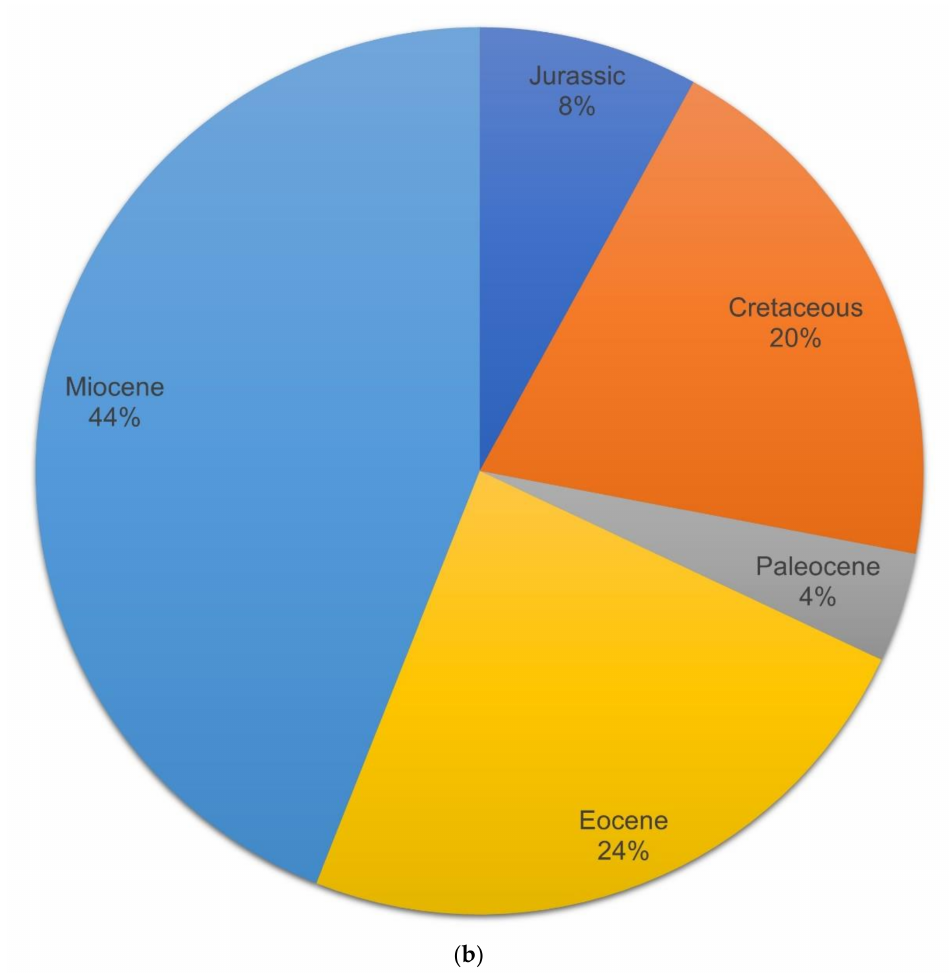
Figure 2. Porphyry copper deposits in the Andes. ( a ) Bar chart comparing estimated numbers of undiscovered deposits predicted by the 2005 assessment with numbers of deposits known in 2021 by permissive tract. See Table 1 for key to tracts. ( b ) Pie chart showing distribution of deposits known in 2021 by